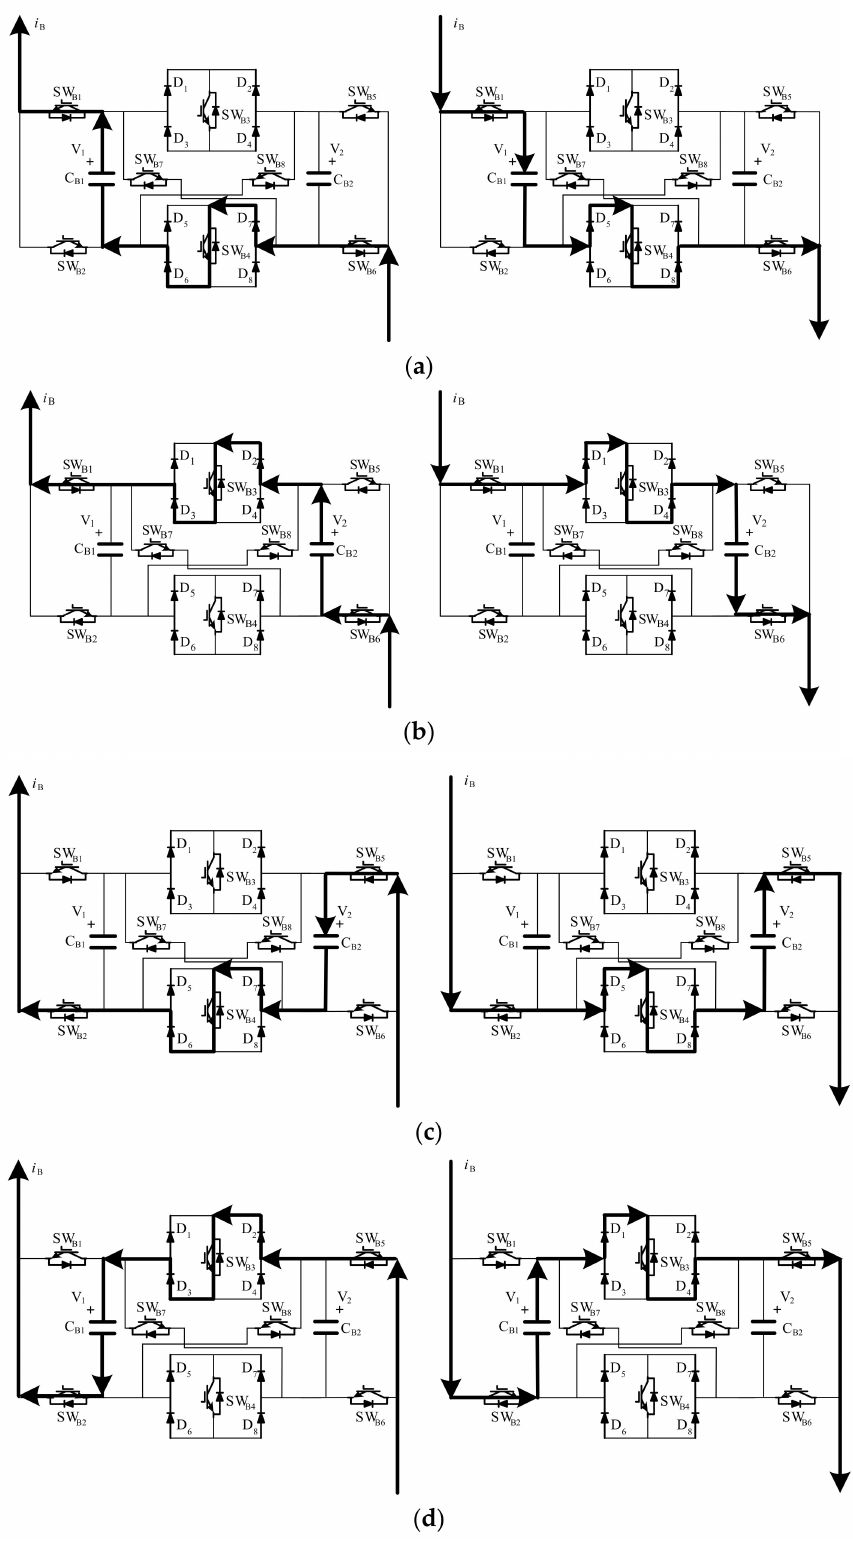
Figure 10. Circuit working state when C B 1 and C B 2 are charged and discharged: ( a ) level 8; ( b ) level 6; ( c ) level 4; ( d ) level